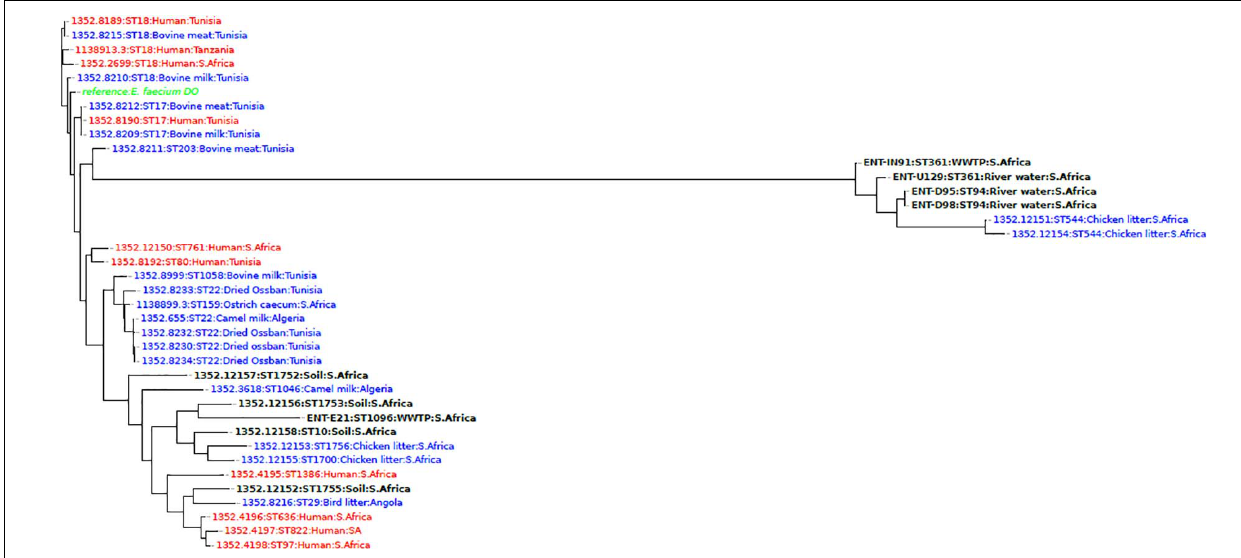
FIGURE 2 | A phylogenomic tree showing the relationship of E. faecium isolates from this study with African isolates from humans (red), animals (blue), and the environment (black) obtained from the PATRIC database (https://www.patricbrc.org/).